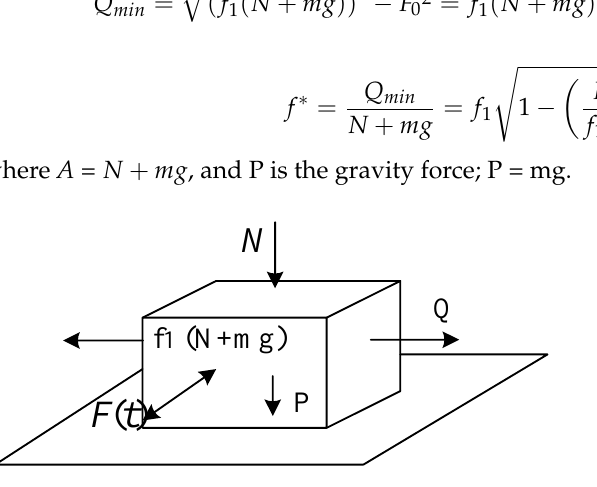
Figure 3. The model of vibration vertical to the friction and the normal pressure.